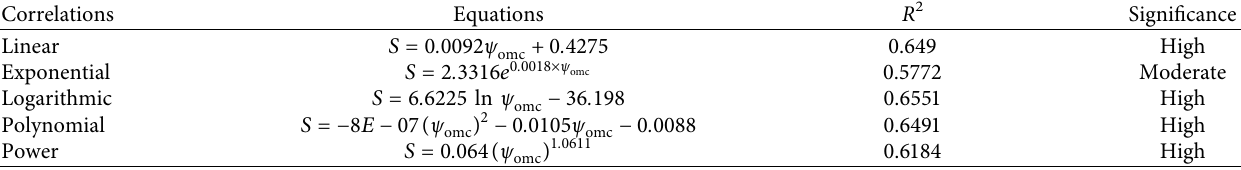
Table 8: Summary of suction-based correlations for swell potential along with R 2 values.